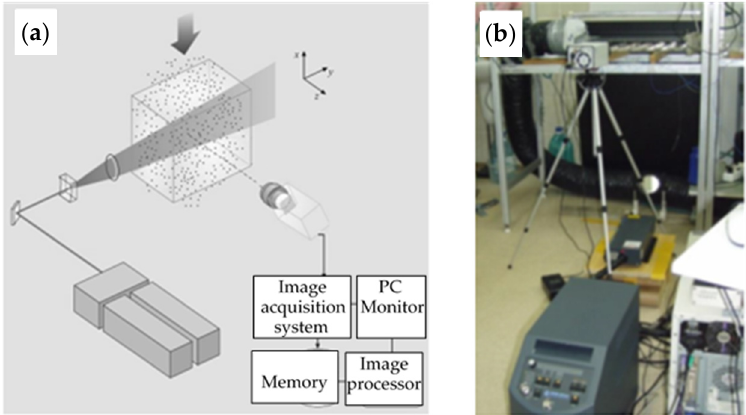
Figure 8. Schematic of PIV measurements ( a ) and view during the experiment ( b ).